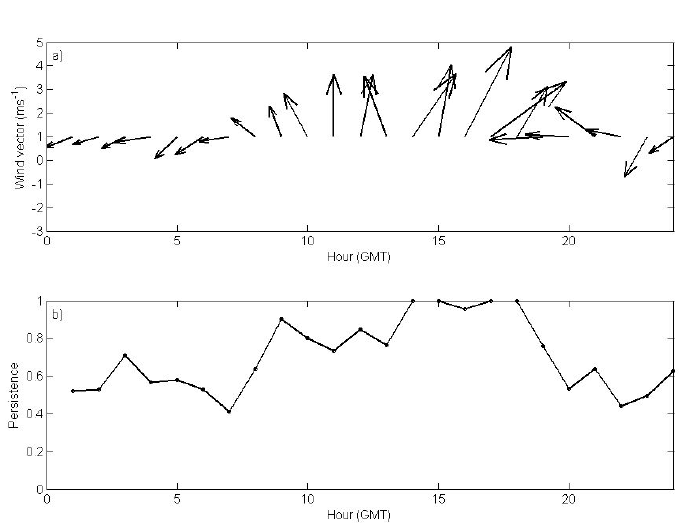
Fig. 5. (a) Diurnal cycle of the near-surface wind vector of the “representative day”, during summer season at the Assergi site, as observed by the radar wind profiler. ( b) Diurnal variation of wind persistence relative to the wind vector in the upper panel (GMT=LT–1).